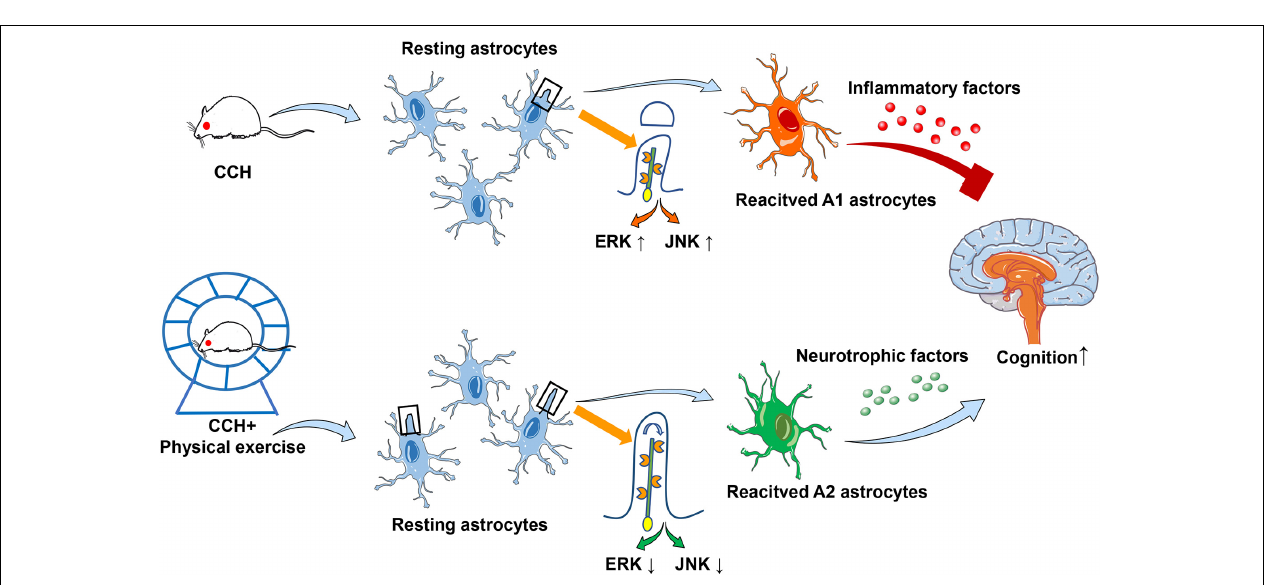
FIGURE 7 | Schematic diagram for the possible mechanism of primary cilia and astrocyte polarization involved in physical exercise induced cognitive improvement in rats with chronic cerebral perfusion.